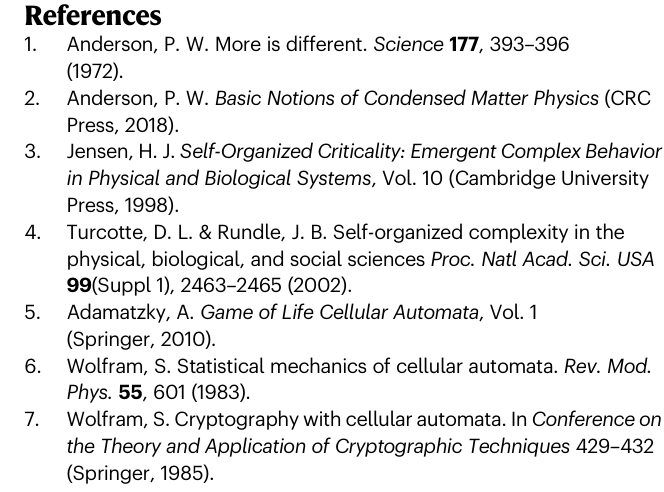
visualizationofmutualinformationnetworkfor L =23at t =9(blue:emulated;red: raw data from Weber; green: post-selected; black: post-selected incoherent uni- form randomness). Where present, error bars represent one standard deviation fromthemeanaveragedoverfourdifferentchainsandcycleswithinthecoherence